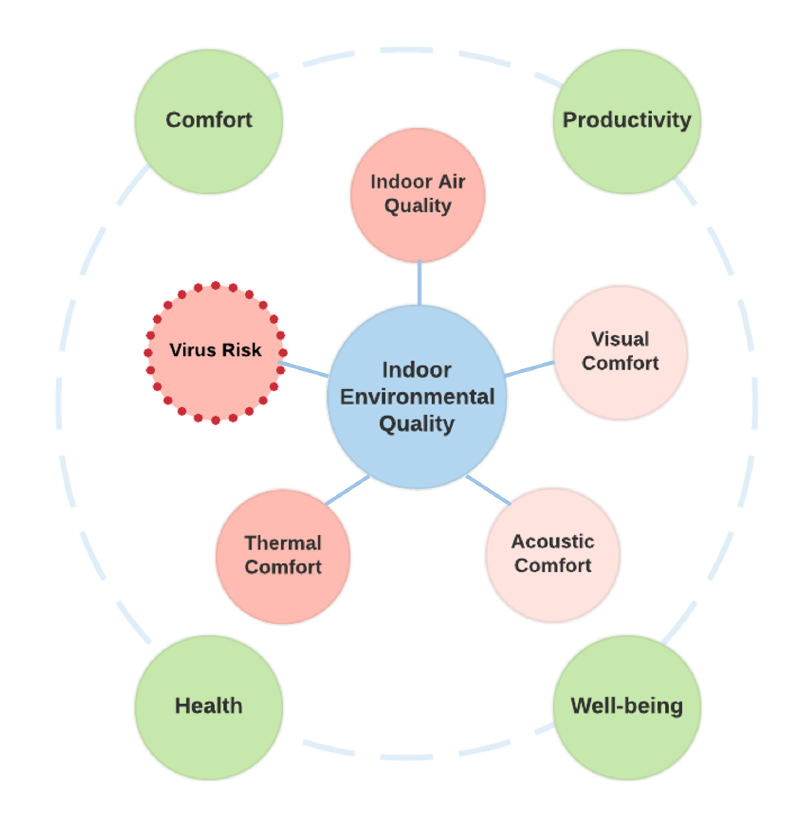
Figure 1. Typical influencing factors of the